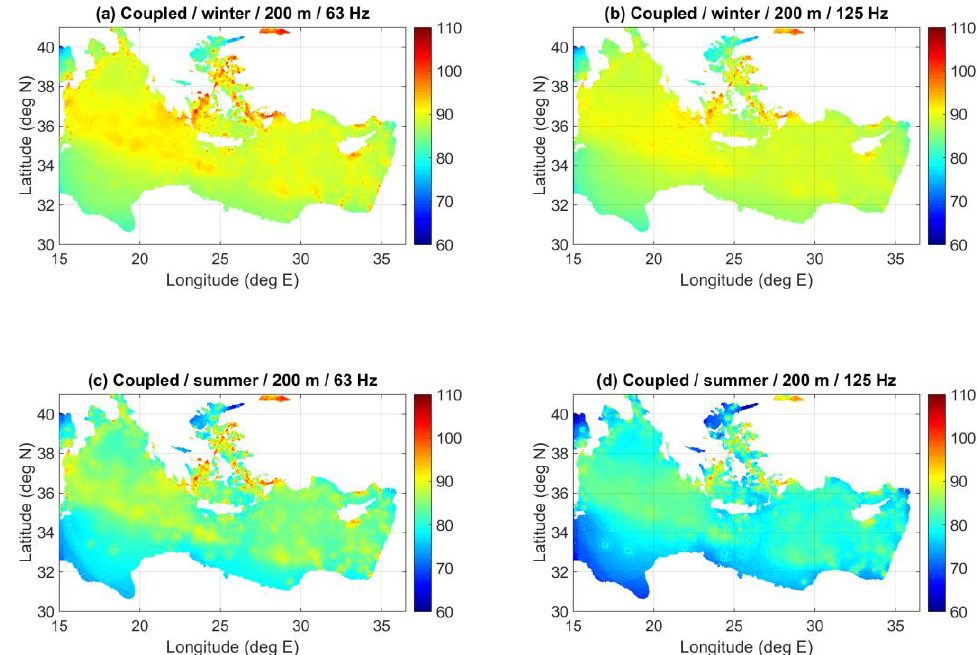
Figure 13. Noise distribution (dB re 1 µ Pa 2 /Hz) from coupled-mode calculation at a depth of 200 m for the source distribution of Figure 10, assuming all sources at 5 m depth, with spectral source levels of 165 dB re 1 µ Pa 2 /Hz @ 1 m at 63 Hz and 155 dB re 1 µ Pa 2 /Hz @ 1 m at 125 Hz, for the winter SVP at ( a ) 63 Hz and ( b ) 125 Hz, and for the summer SVP at ( c ) 63 Hz and ( d ) 125 Hz.